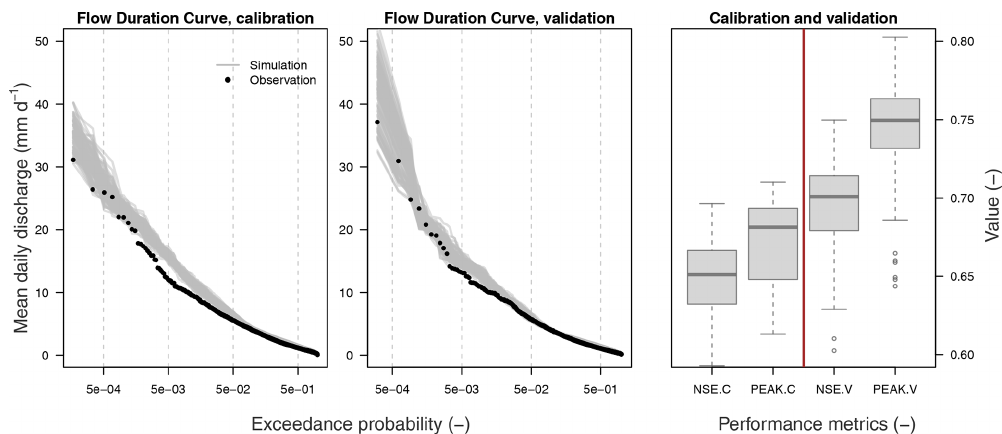
Figure C2. Flow duration curves and model performance metrics for calibration and validation periods over all 100 optimized parameter